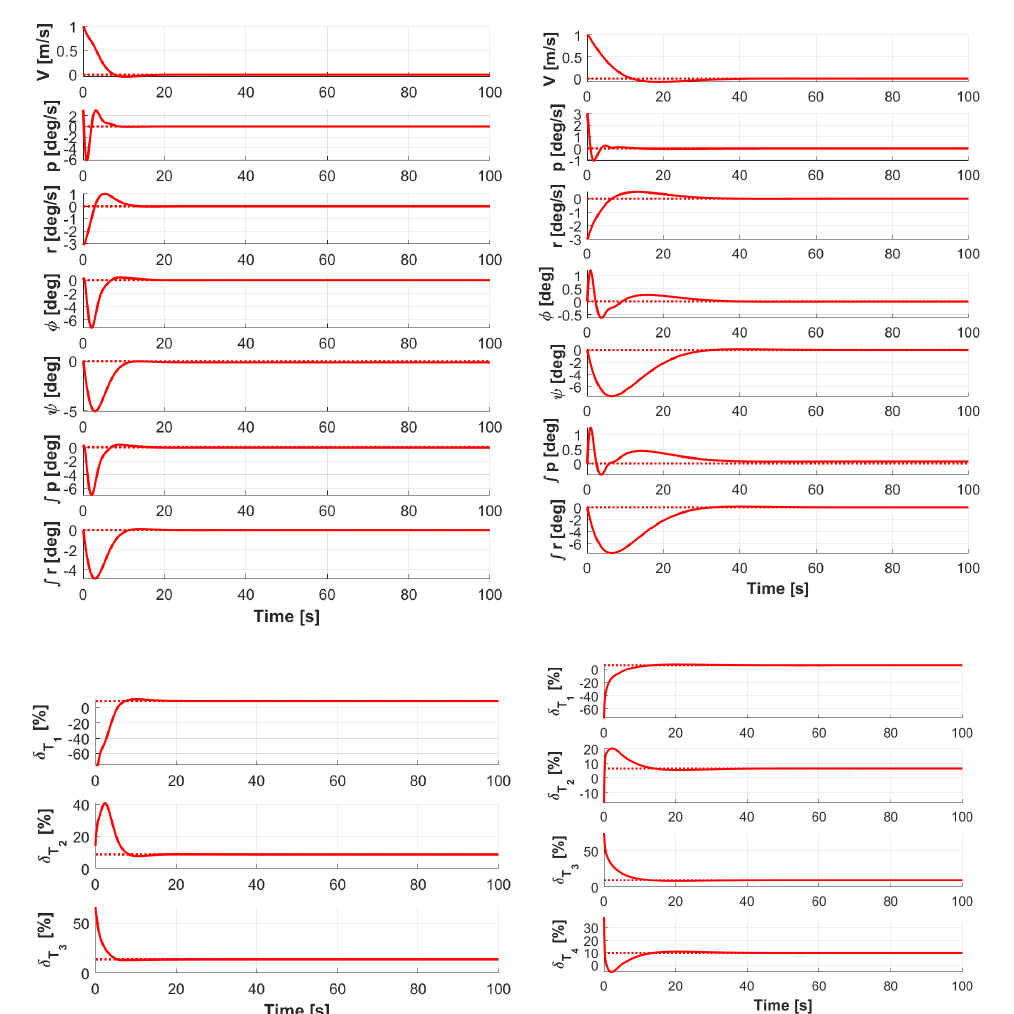
Figure 8. Time-marching simulation of the non-linear airship system subject to artificial stabilization. Left : layout (A). Right : layout (C). Forward flight at 8 m/s, with a perturbation in the initial condition of the states. Top row : longitudinal states. Mid row : lateral-directional states. Bottom row : controls. Dotted line: trim